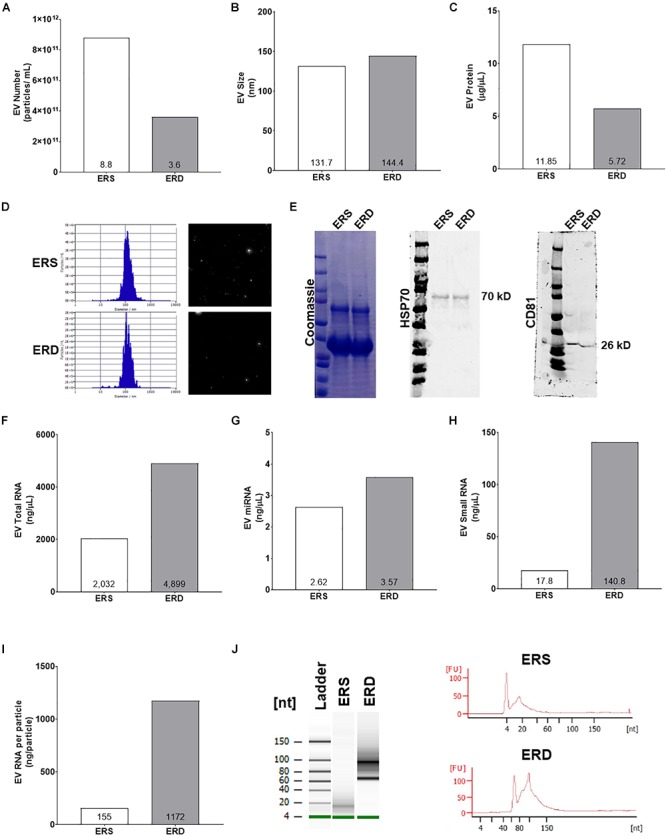
Extracellular vesicles authentication and cargo analysis between the ERS and ERD diets. These data show diet based bovine milk-derived EVs number (A), EVs size (B), EVs protein content (C), ZetaView particle histograms and representative images (D), representative Western blots for Coomassie, heat shock protein 70 (HSP70), and cluster of differentiation 81 (CD81) (E), EVs total RNA content (F), EVs miRNA content (G), EVs small RNA content (H), EVs RNA content per particle number (I). (J) Contains representative gel and electropherograms from Bioanalyzer analysis. ERS, EVs and RNA-sufficient; ERD, EVs and RNA-depleted.